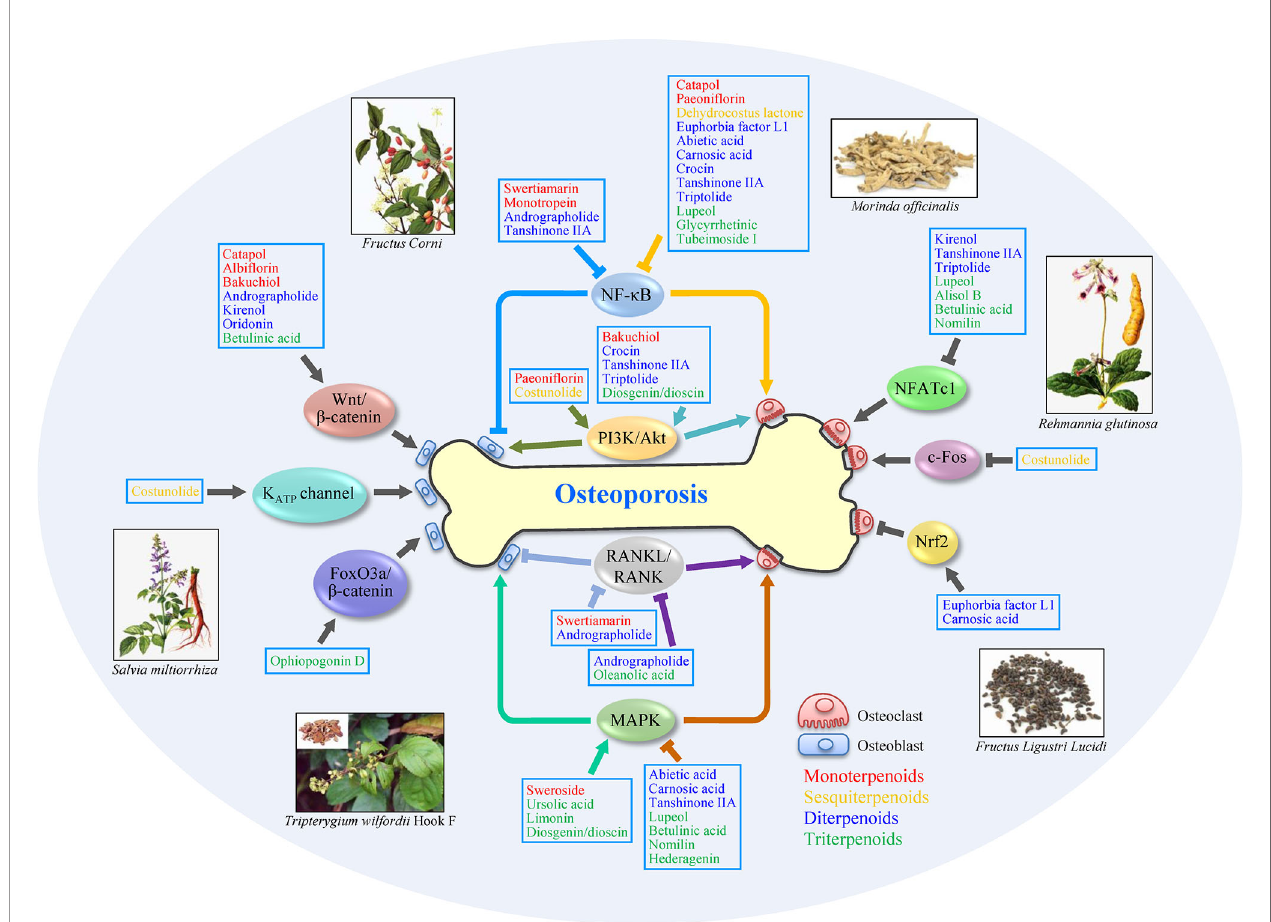
FIGURE 3 | Schematic of anti-osteoporosis mechanisms of terpenoid on osteoblasts and osteoclasts. The activation of MAPK, PI3K/Akt, Wnt/ b -catenin signaling pathways and so on, or inhibition of NF- k B and RANKL/RANK signaling pathways, can promote cell proliferation or differentiation in osteoblasts, which bene fi ts osteoporosis treatment. Meanwhile, the inhibition of MAPK, NF- k B, RANKL/RANK, and NFATc1 signaling pathways, or activation of PI3K/Akt and Nrf2 signaling pathways, also exerts potential therapeutic ef fi cacy via regulating osteoclasts. Some terpenoids, such as andrographolide and tanshinone IIA, show anti-osteoporosis effect by modifying multi-targets. Arrows ( ↓ ) indicate activation of a factor or positive effect on indicated cell type, while inverted T marks ( ⊥ ) indicate inhibition or negative effect. Subclass of terpenoids is distinguished with different colors: monoterpenoids (red), sesquiterpenoids (yellow), diterpenoids (blue), and triterpenoids